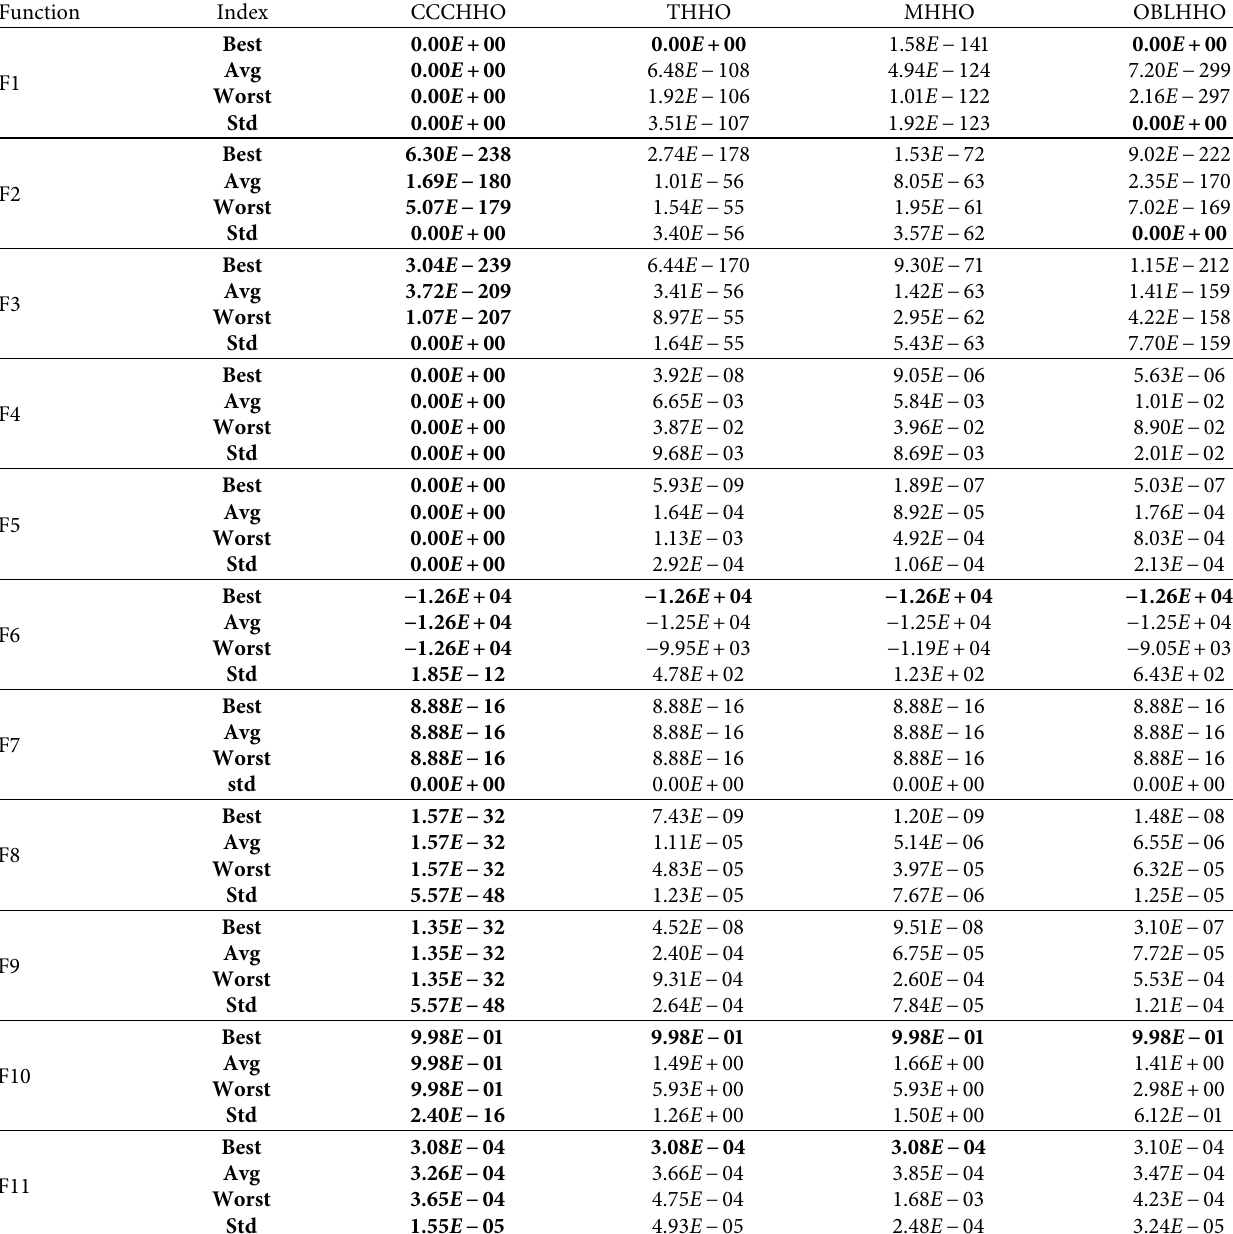
Table 3: The result of comparison of CCCHHO with the improved